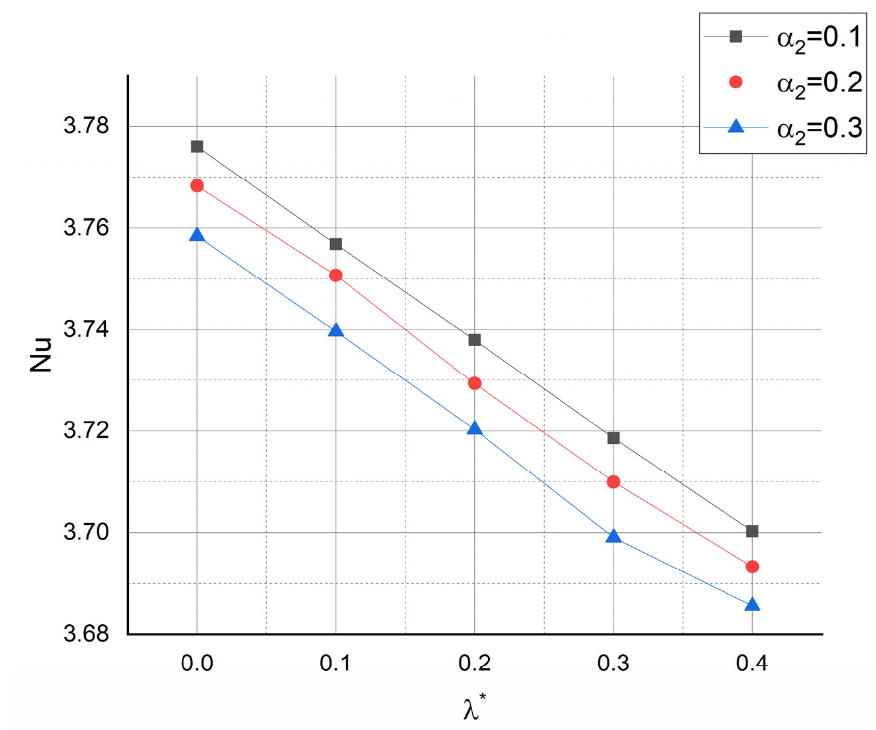
Figure 12. Influence of α 2 and λ ∗ on Nu .